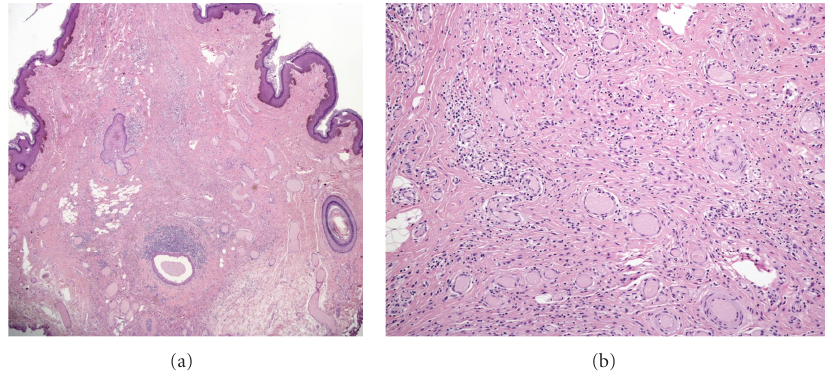
Figure 2: (a) Photomicrograph (hematoxylin-eosin, original magnification × 2) showing pedunculated lesion covered with skin. Note the proliferation of mesenchymal cells in richly vascularized fibrous stroma. (b) Photomicrograph (hematoxylin-eosin, original magnification × 10) showing a mixture of hypercellular and hypocellular edematous areas with abundant small- to medium-sized vessels.